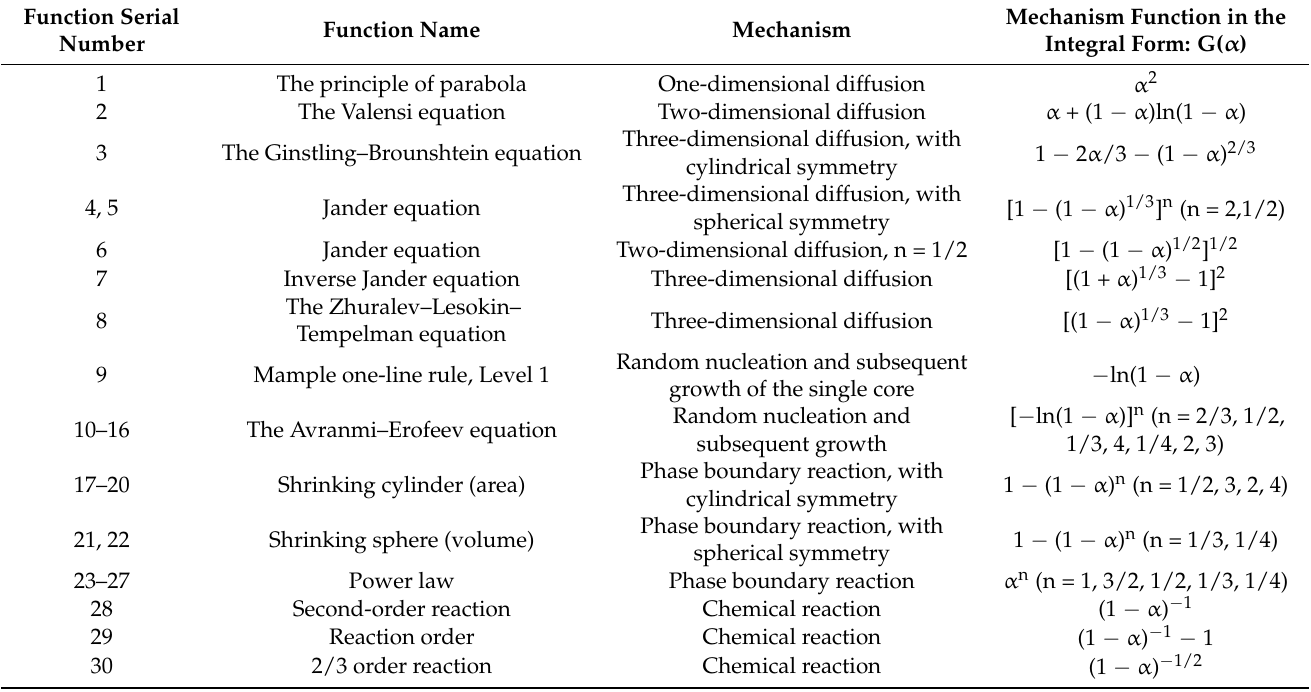
Table 2. Thirty reaction mechanisms and functions of